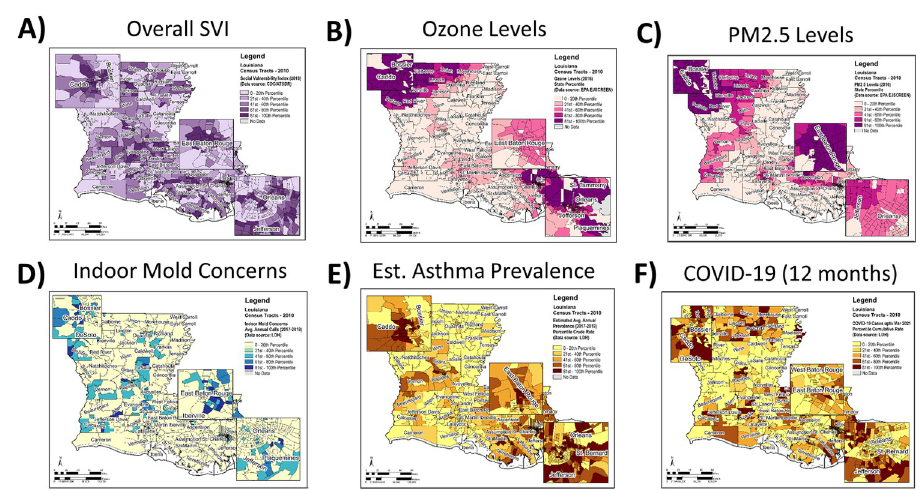
Fig 2. Spatial analysis of social and environmental vulnerability, asthma and COVID-19. Darker colors for each measure indicate higher percentile ranks. Most counties in LA had census tracts with SVI (A) above the median. Ozone (B) and PM 2.5 (C) were higher in the northwest and southeastern parts of the state. Indoor environmental quality concerns (mostly in the form of mold complaints) were also reported from all over the state (D) . Estimated prevalence of asthma (E) was often above the median in census tracts located in the northwestern, western, southern and southeastern parishes. At the 12-month time point, cumulative COVID-19 incidence rates (F) were higher in the northern, northwestern and southeastern parts of the state.